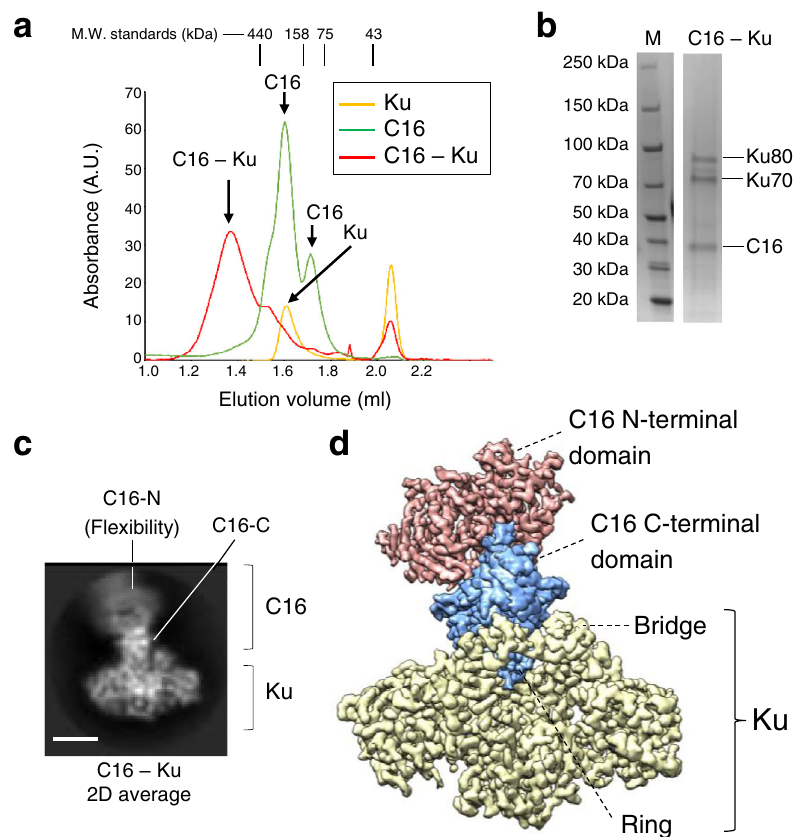
Fig.2|Puri fi cationandcryoEMoftheC16 – Kucomplex.a SECofC16,Kuandthe mixture of both proteins. The elution volume for the peaks of standard proteins Ferritin (440kDa), Aldolase (158kDa), Conalbumin (75kDa) and Ovalbumin (43kDa) are indicated on top of the chromatogram. M.W. stands for Molecular Weight. b Right:SDS-PAGEofC16 – Kucomplex.Left:MolecularWeight(M)markers run in the same SDS-PAGE. The experiment shown in a and b was repeated three times with similar results. Source data are provided as a Source Data fi le. c One